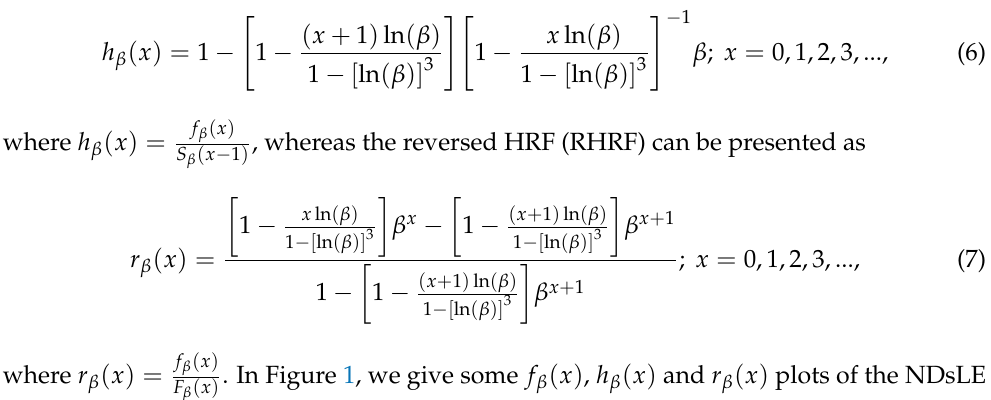
f β ( x ) where r β ( x ) = . In Figure 1, we give some f β ( x ) , h β ( x ) and r β ( x ) plots of the NDsLE F β ( x ) model under some selected parameter values.